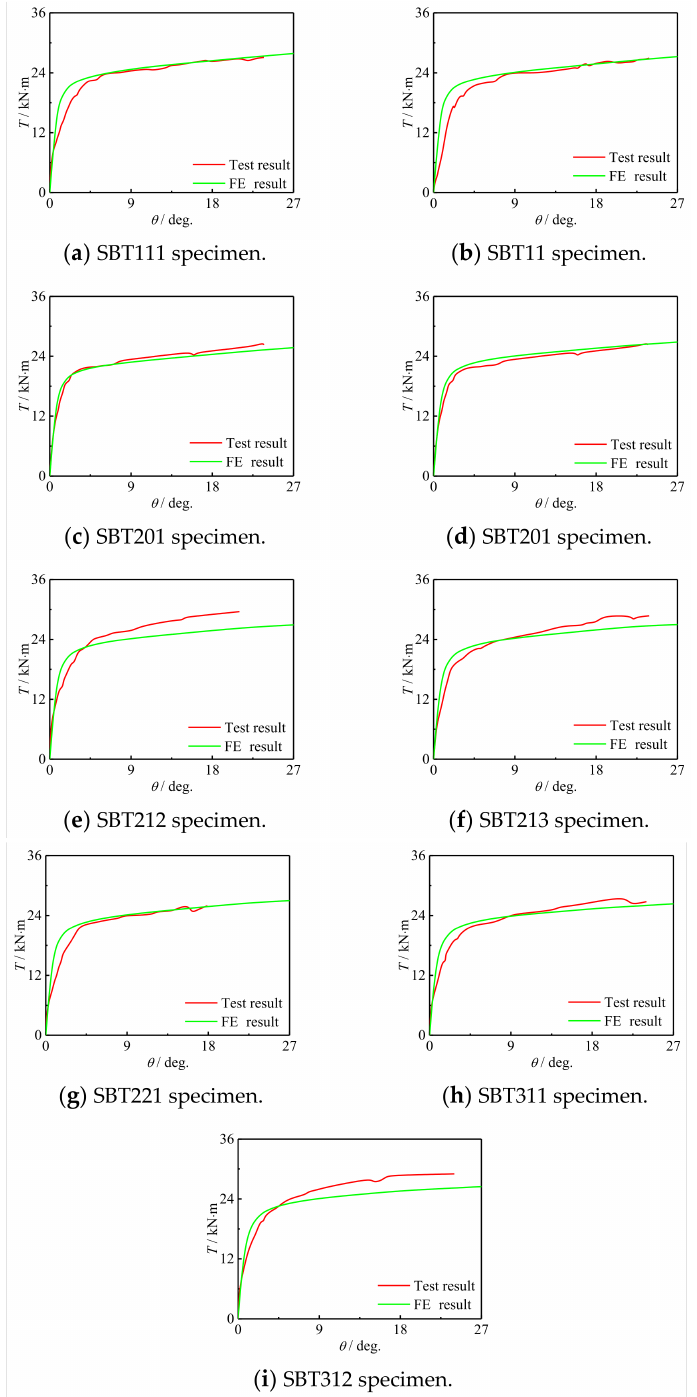
Figure 9. The comparison T - θ